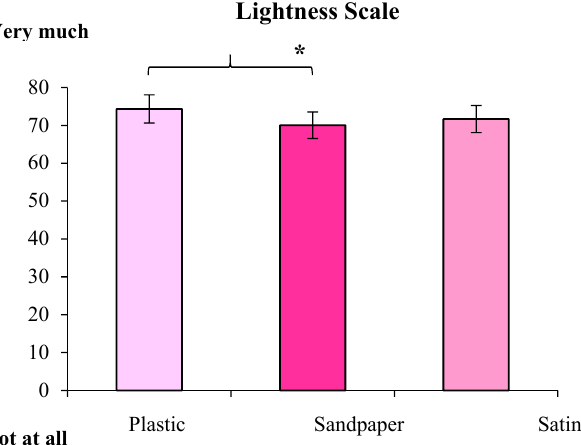
Figure 4. The participants’ mean judgments on the scale measuring lightness perception for both kinds of water as a function of the texture of the plastic glass in which the liquid was served. Error bars represent the standard error of the mean. Asterisks represent Newman–Keuls significant differences at p < 0.05.